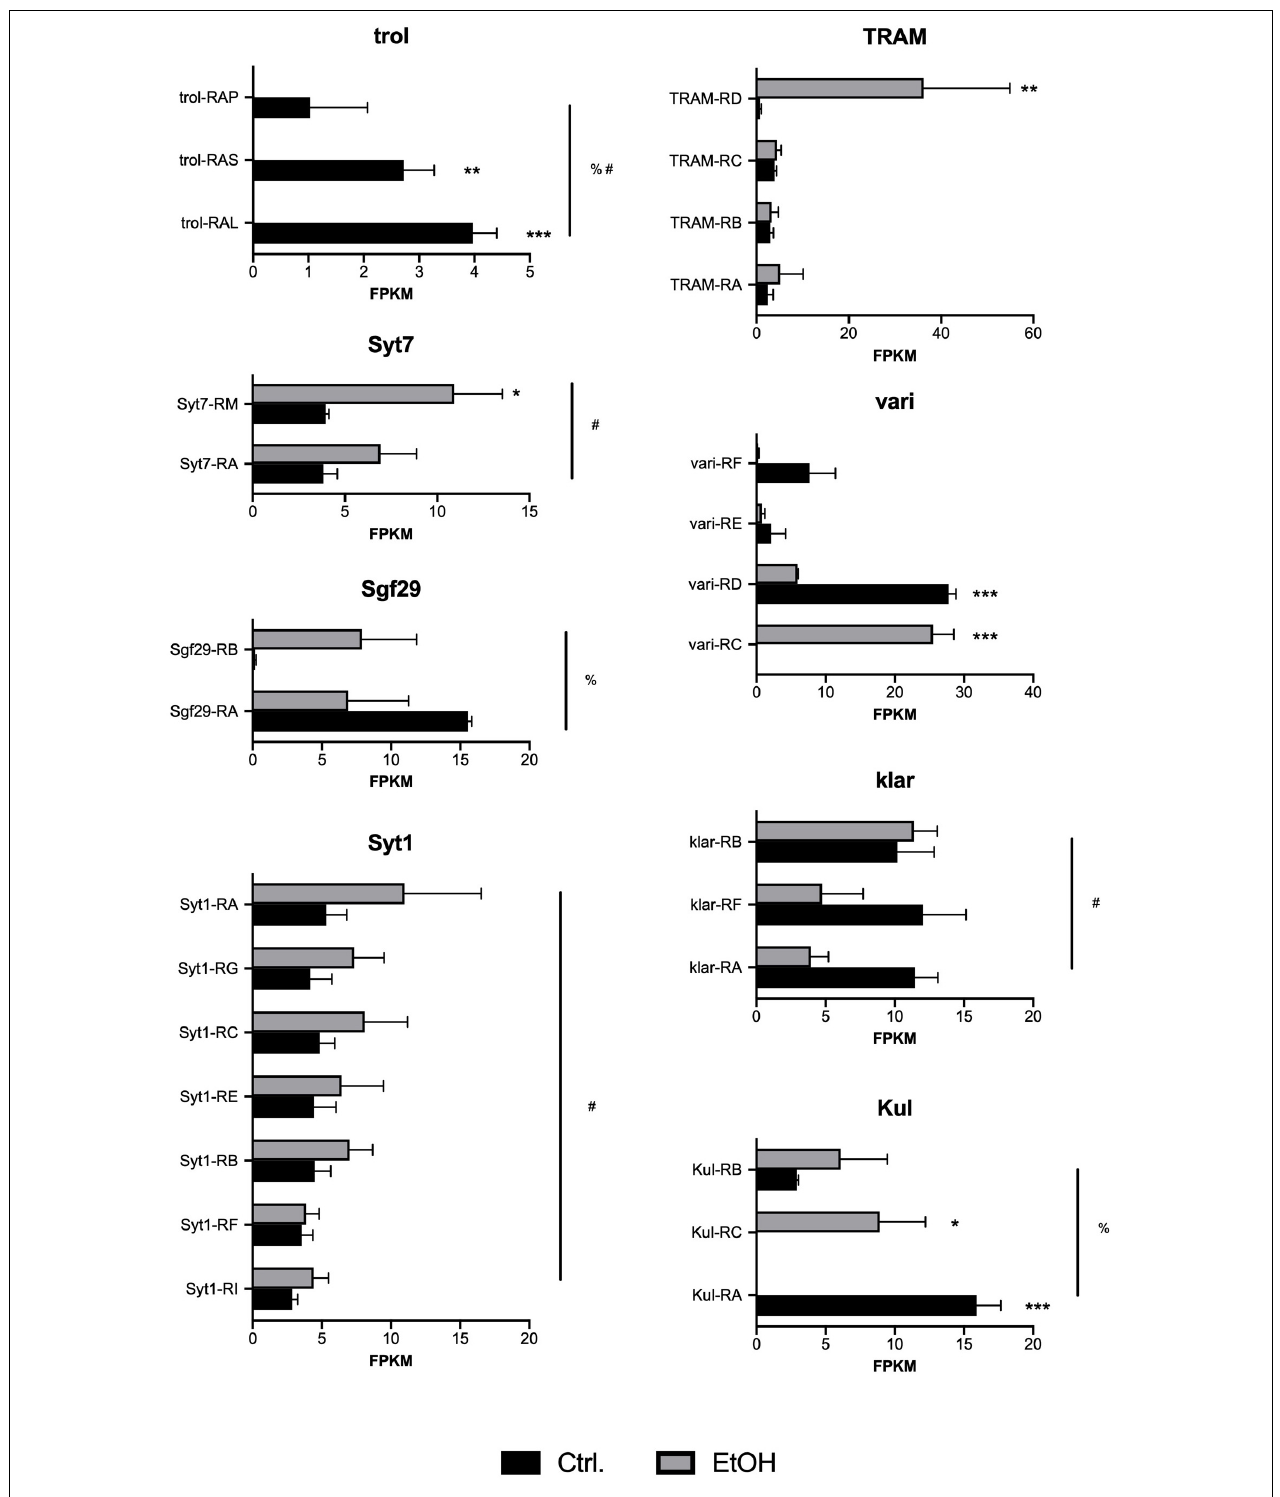
FIGURE 2 | Transcript-specific expression induced by chronic alcohol exposure. Shown are FPKM counts in control (Ctrl, black bars) and alcohol treated (EtOH, gray bars) larvae for independent transcriptional isoforms of eight selected genes: trol , Syt7 , Sgf29 , Syt1 , TRAM , vari , klar , and Kul . Significant differences were detected by Two-way ANOVA followed by Sidak’s multiple comparisons test. Asterisks denote significant differences between control and alcohol treated samples (* p < 0.05, ** p < 0.01, *** p < 0.001). The pound sign (#) denotes a significant effect of treatment on all transcripts within the gene (p < 0.05). The percent (%) sign denotes a significant interaction between treatment and transcript identity ( p <